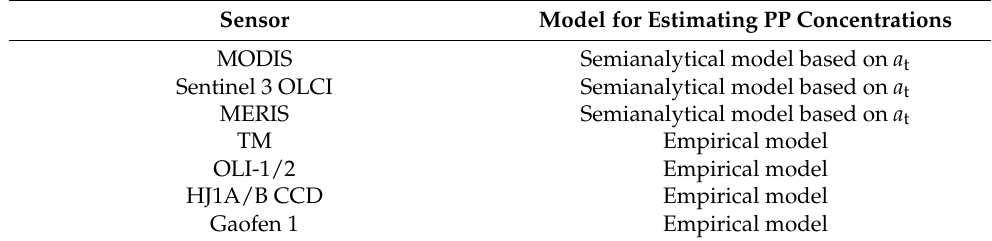
Table 2. Selection of common sensors for estimating PP concentrations in Hongze Lake.